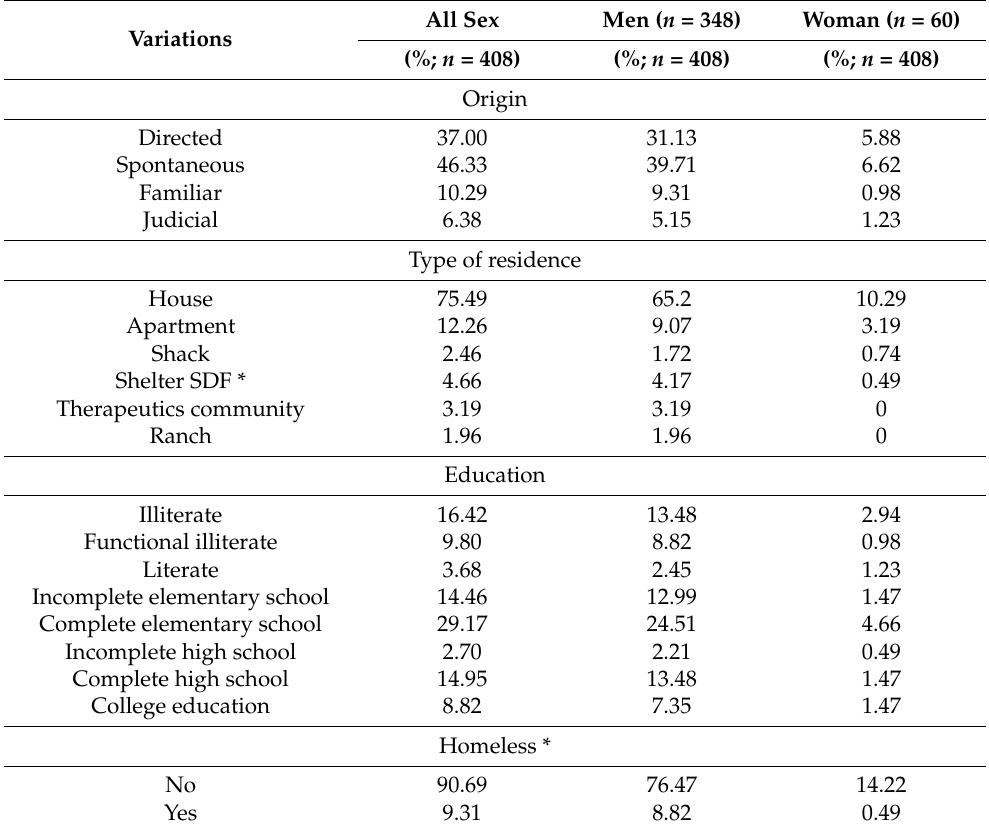
Table 1. Schooling profile, type of housing, and type of admission of elderly drug users assisted at CAPS-AD from DF between 2000 and